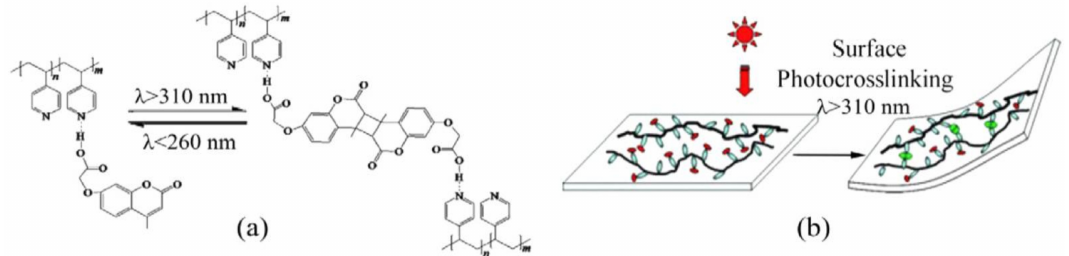
Figure 38. ( a ) Reversible photocross-linking of P4VP partially complexed with 7-(carboxymethoxy)-4-methylcoumarin through hydrogen bonding. ( b ) Scheme of the mechanism underlying the photoinduced bending of the film. Repub- lished with permission of the Royal Society of Chemistry, from [203]; permission conveyed through Copyright Clearance Center, Inc.